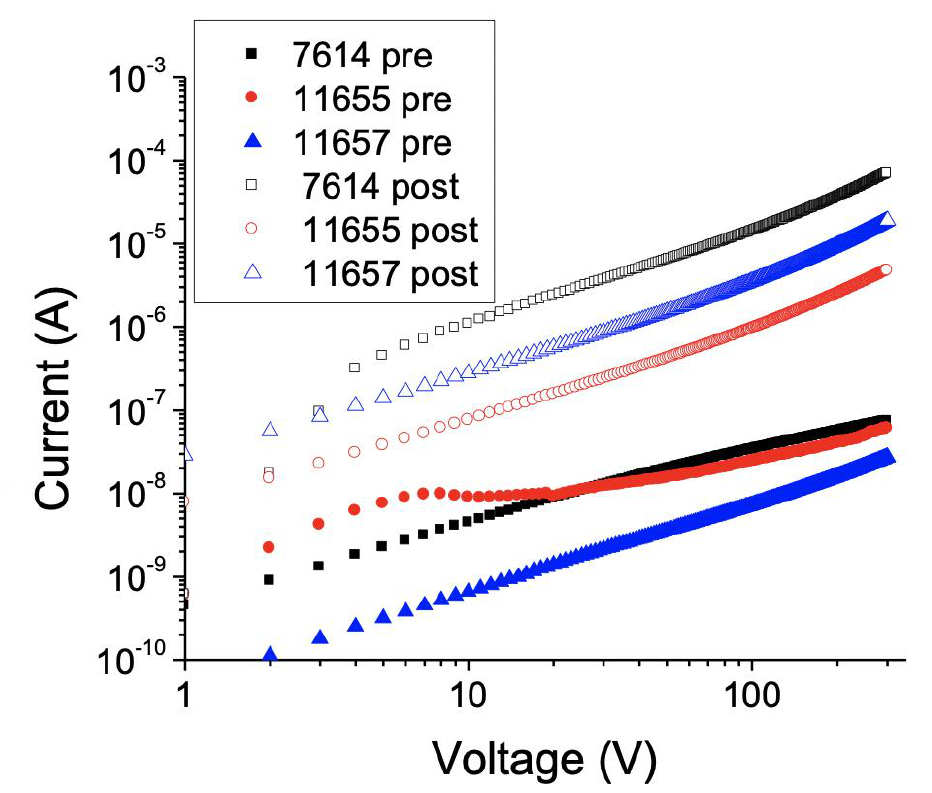
Figure 9. Current–voltage (I-V) characteristics for “pre-wash” and “post-wash” xylindein films made from extracts of di ff erent species and strains, including C. aeruginascens strains UAMH 7614 and UAMH 11655 and C. aeruginosa strain UAMH 11657. Testing was carried out on interdigitated Au electrodes with a 25 µ m gap. C. aeruginascens yielded higher quality xylindein, with strain UAMH 7614 showing the best